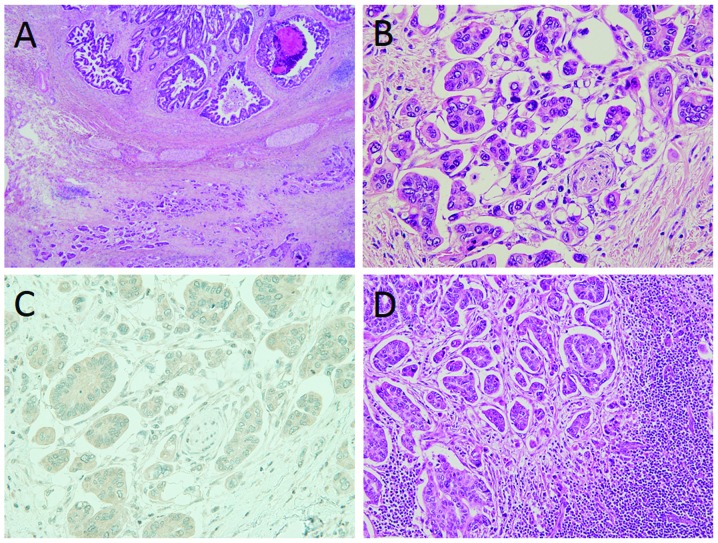
Histological findings of IMPC of the extrahepatic bile duct. IMPC component was found at the invasive front of the tumor (A, top left). Cancer cells were characterized by small round to ovoid micropapillary tumor cell clusters with no fibrovascular cores, lying within clear stromal spaces (B, top right). Immunohistochemical staining for D2-40 revealed the absence of endothelial lining cells in clear spaces surrounding the tumor clusters (C, bottom left). Lymph node metastasis also consisted of the IMPC (D, bottom right). The tumor clusters were similar to the primary lesion. IMPC, invasive micropapillary carcinoma.